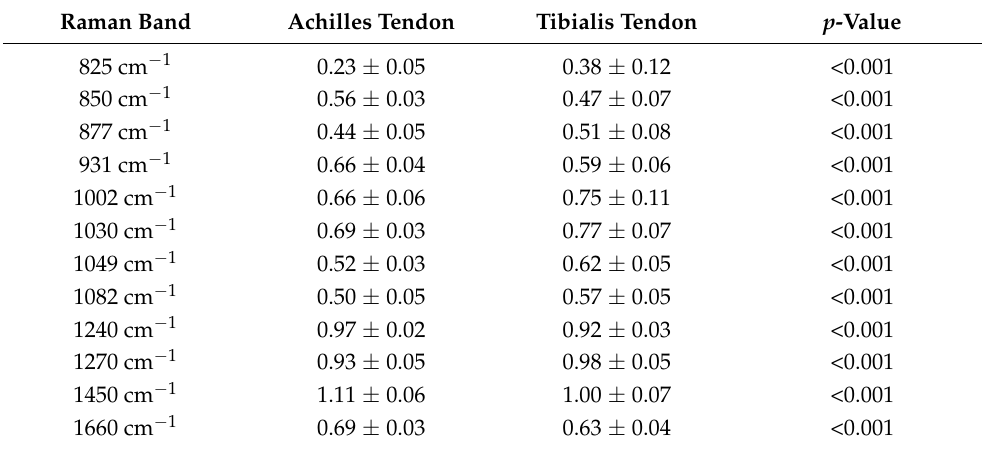
Table 2. Raman band intensities between Achilles tendon (n = 80) and tibialis anterior tendon (n = 80). Raman Band Achilles Tendon Tibialis Tendon p -Value 825 cm −